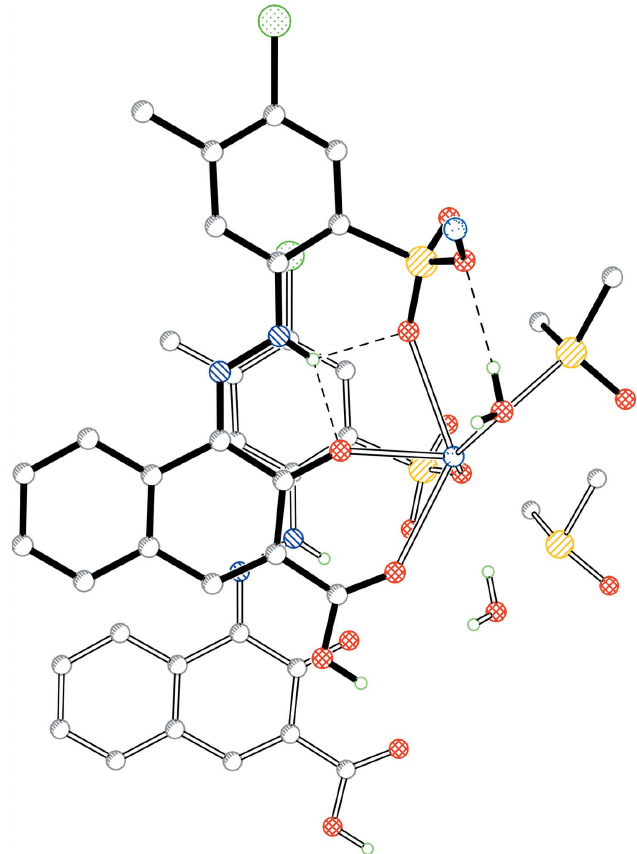
Figure 3 (cid:2) -stacking of two anions, one drawn with full bonds and the other one with open bonds. the shortest distance C6 (cid:2) (cid:2) (cid:2) C12 of 3.303 (5) A˚ . The N–NH unit